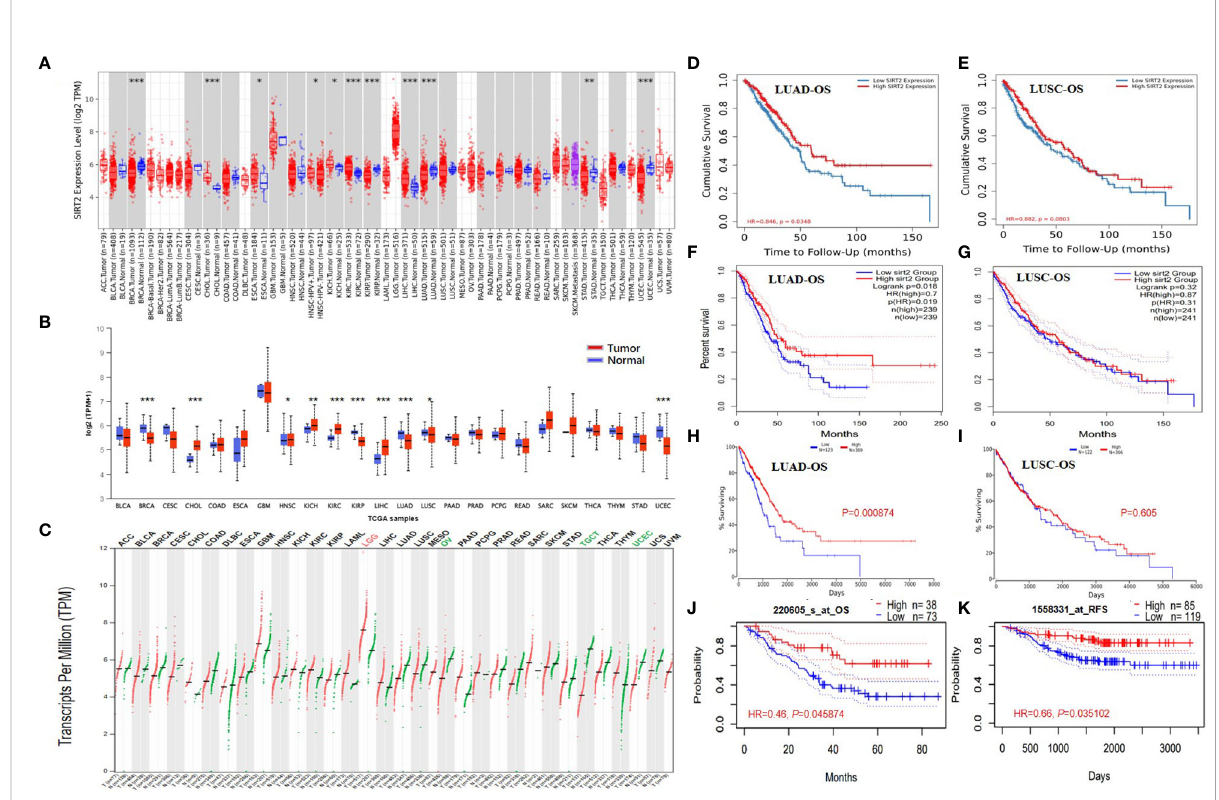
FIGURE 1 SIRT2 expression levels in different types of human cancers in different databases. Survival curves comparing the high and low expression of SIRT2 in LUAD and LUSC. SIRT2 expression pro fi le across all tumor samples and paired normal tissues (Dot plot) via TIMER2.0 (A) and UALCAN (B) . P- value Signi fi cant Codes: 0 ≤ *** < 0.001 ≤ ** < 0.01 ≤ * < 0.05 ≤ . < 0.1. The threshold was set as follows: P -value of 1E-6, fold change of 2, and gene ranking top 5%. SIRT2 expression pro fi le across all tumor samples and paired normal tissues via GEPIA 2.0 (C) , each dots represent the expression of samples. The gene expression pro fi le across all tumor samples and paired normal tissues (Bar plot). The height of bars represents the median expression of certain tumor type or normal tissue (each dot representing a distinct tumor or normal sample). Overall survival curves comparing the high and low expression of SIRT2 in LUAD (D) and LUSC (E) in the TIMER2.0. Overall survival curves comparing the high and low expression of SIRT2 in LUAD (F) and LUSC (G) in the GEPIA. A comparison of overall survival curves in Oncolnc database for LUAD (H) and LUSC (I) based on SIRT2 expression levels. The PrognoScan database compares high and low expressions of SIRT2 in LUAD based on OS (J) and Distant Metastatic Free Survival (K)